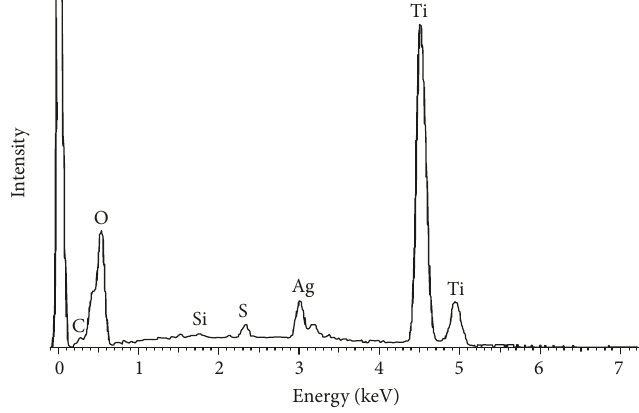
Figure 3: EDS patterns of nano 0.75 Ag-TiO